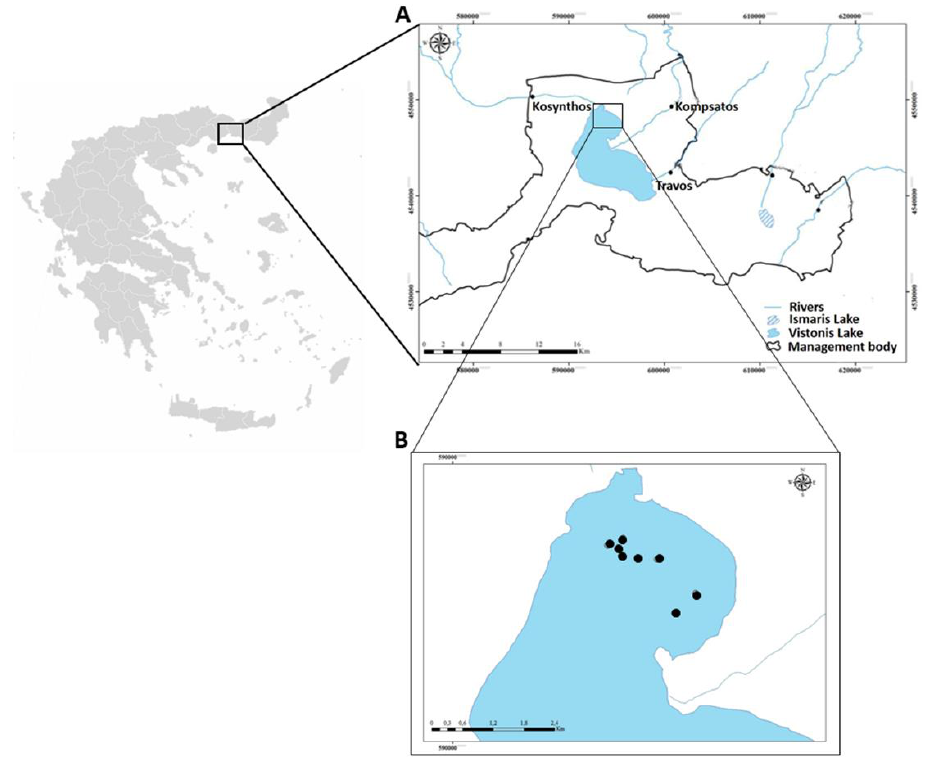
Figure 1. Map of the study area (Vistonis Lake, Northern Greece) ( A ) and sampling stations indicated with black dots ( B ) (Reprinted with permission from ref. [30]. Copyright 2108, Copyright Owners Assoc. Professors Dimitra Bobori and Efthimia Antonopoulou and Dr. Emmanouil Tsakoumis).